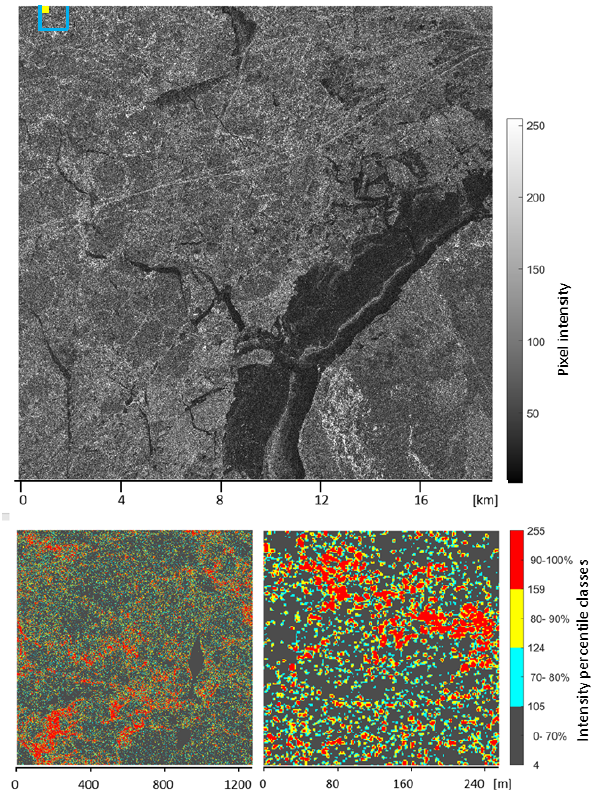
Figure 5. The 15200 × 15200 stripmap image with the locations of 1024 × 1024 (blue) and 200 × 200 (yellow) subimages indicated (upper panel). The 1024 × 1024 and 200 × 200 subimages (lower